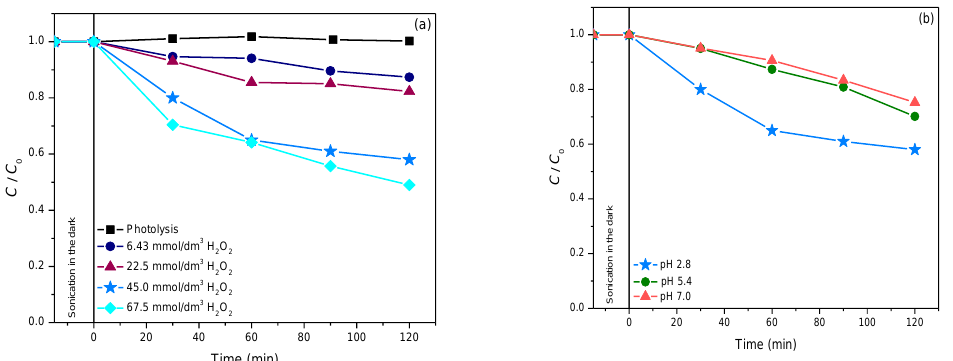
Figure 5. ( a ) The influence of initial H 2 O 2 concentration on the kinetics of thiacloprid (0.38 mmol/dm 3 ) photodegradation in the presence of 0.42 mg/cm 3 12ZrO 2 /Fe 3 O 4 at pH 2.8 and using solar irradiation. ( b ) The influence of initial pH on the thiacloprid (0.38 mmol/dm 3 ) photodegradation efficiency in the presence of 45 mmol/dm 3 H 2 O 2 , 0.42 mg/cm 3 12ZrO 2 /Fe 3 O 4 and using solar irradiation.